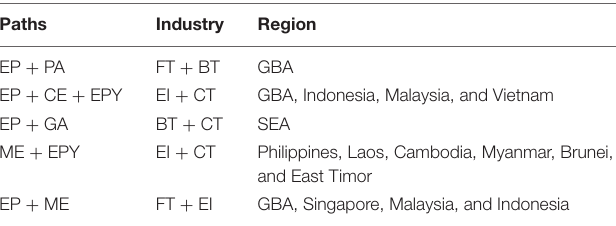
TABLE 7 | Distribution of factors for establishing cross-regional and multi-industry startups. Paths Industry